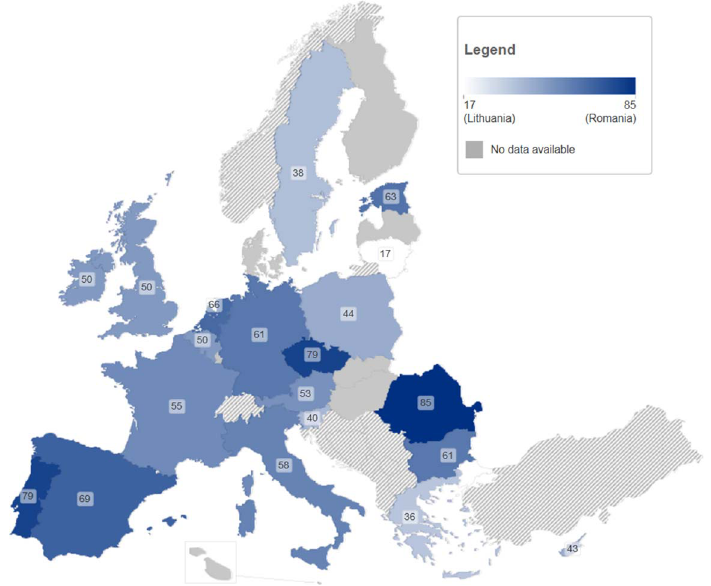
Figure 4. Proportion (%) of HCV infections among PWID that are genotypes 1 or 4.